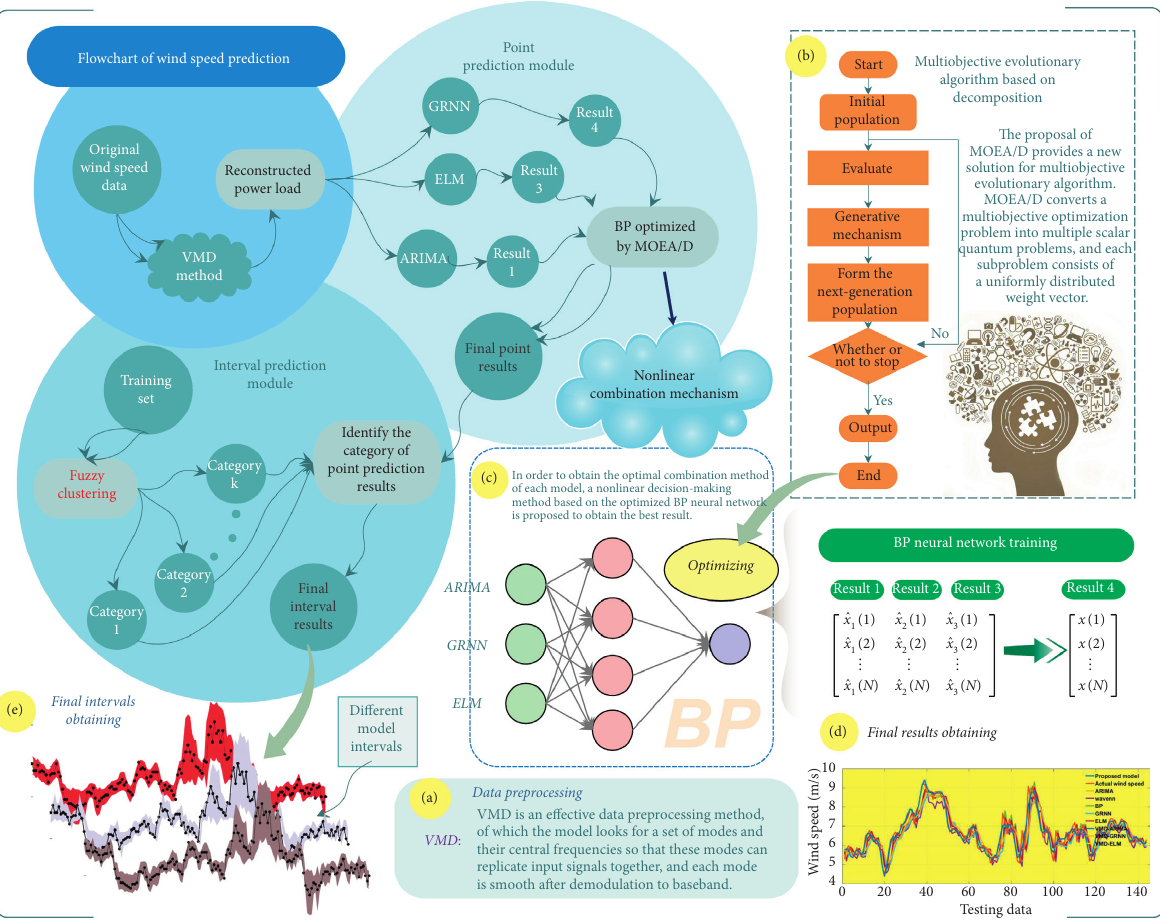
Figure 1: The flowchart of wind speed forecasting by double hybrid model. The model construction steps are recorded in the blue circle, and the methods displayed in the specific model are divided into five parts of A, B, C, D, and E. D and E show the results of point prediction and interval prediction,